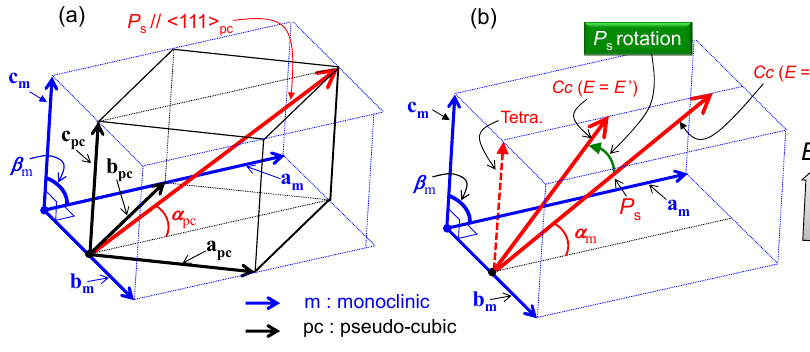
Figure 3. Unit cells of pseudo-cubic (pc) and monoclinic (m) structures: ( a ) the relation between the pc cell and the monoclinic cell (the C base centered one with 2/ m symmetry) vector is aligned adapted for the SR-XRD analysis. In rhombohedral R 3 c symmetry, the P s along <111> and forms an angle of α with the a - b plane. ( b ) depicts the schematic pc pc pc pc rotation by applying an E . In this monoclinic cell, α is defined as the image of the P s pc angle of the P vector with the a – b s m m